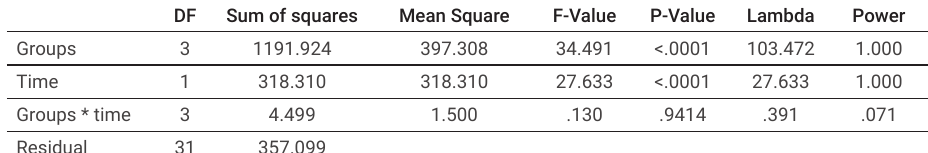
Table 1. ANOVA results for microshear bonding strength